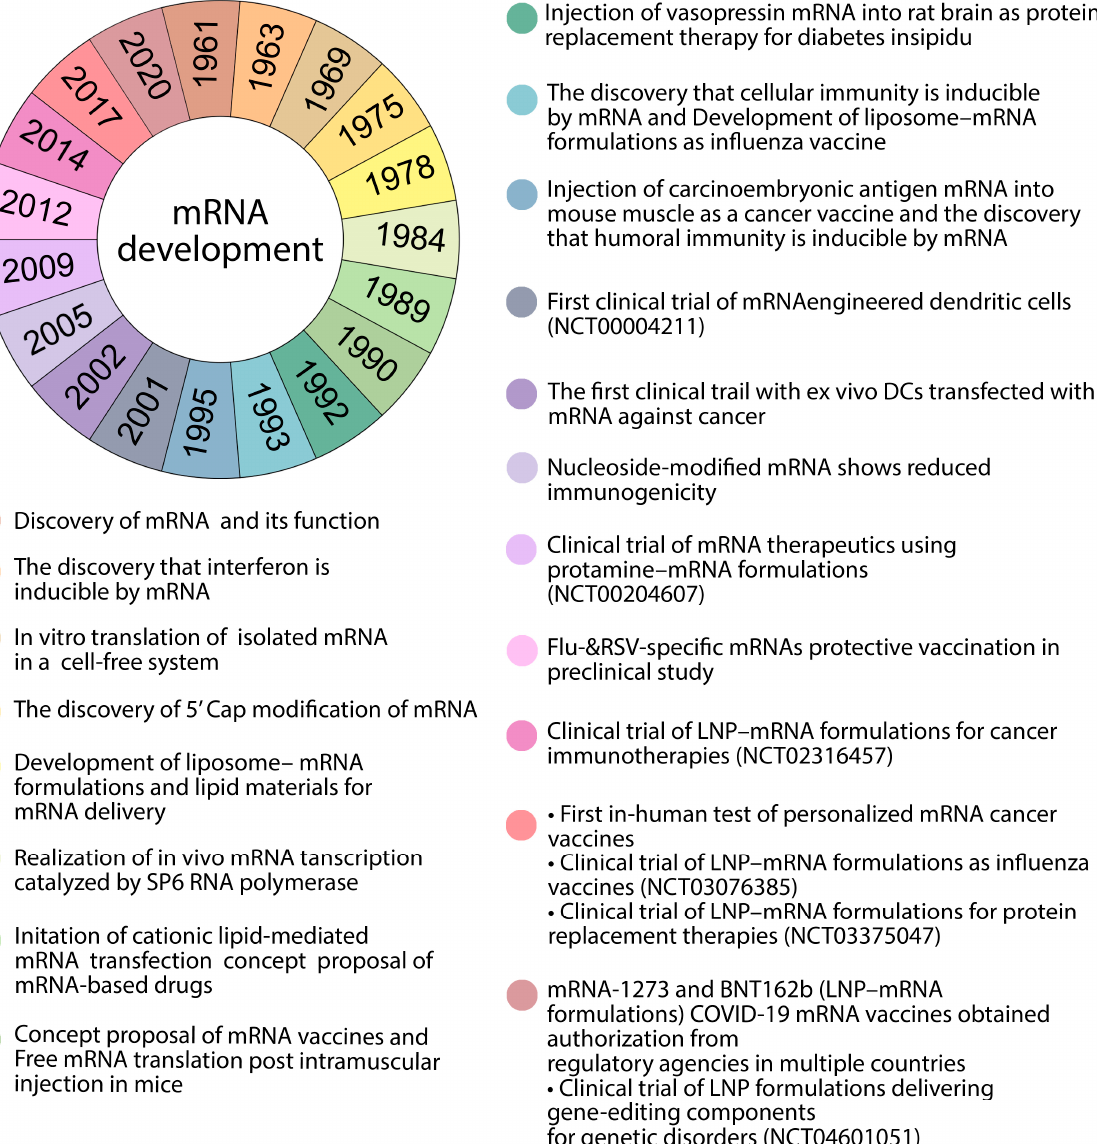
Figure 1. Timeline of selected significant events in mRNA development .